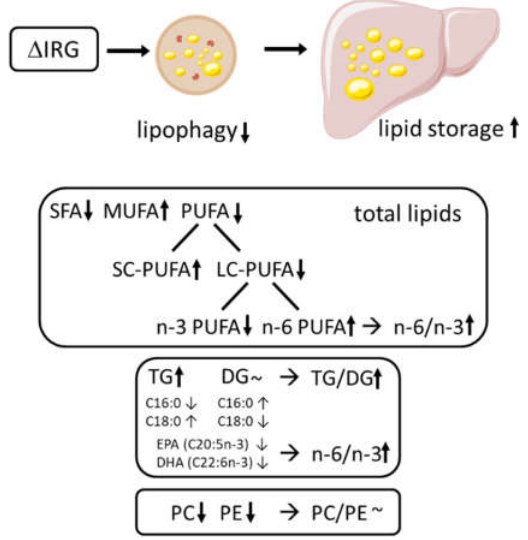
Figure 5. Decreased lipophagy in ΔIRG mice resulted in increased lipid storage in the liver and changes in the hepatic lipidome. The main effects included an overall reduction in LC-PUFA content and an increased n-6/n-3 ratio, which was due to the depletion of n-3 PUFAs and an increased TG/DG ratio. Although the phospholipid classes PC and PE were reduced, the PC/PE ratio was not affected.